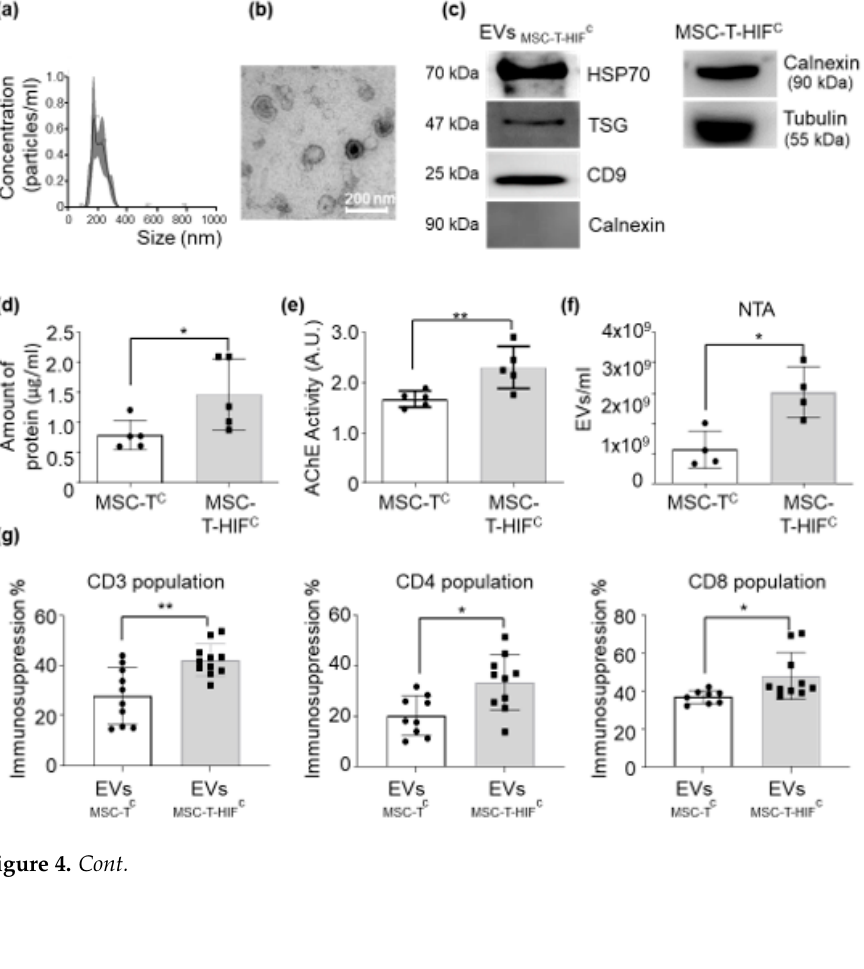
Figure 4. MSC-T-HIF c -derived EVs (EV MSC-T-HIFc ) display enhanced immunosuppression properties. ( a ) Representative images of EVs collected from MSC-T-HIFc evaluated by nanoparticle tracking analysis (NTA). ( b ) Representative electron microscopy images of isolated EVs collected from MSC-T-HIFc. Scale bar: 200 nm. ( c ) Representative Western blots of Hsp70, TSG101 and CD9 pro- teins in EVs. Absence of calnexin demonstrates a pure EV preparation. Cells were used as cal- nexin-positive controls ( d ) Concentration of protein of EVs extracted from 100 mL of culture me- dium from 1 × 10 7 cells that were resuspended in 100 μ L of PBS. Graphs represent mean ± SD of six independent experiments. Paired t -test was used for statistics. ( e ) Quantification of acetylcho- linesterase activity in EV MSC-T c and EV MSC-T-HIF c . Values are represented as relative to the EV MSC-T c value. Graph represents mean ± SD of three independent experiments. Paired t -test was used for statistics. ( f ) Amount of EVs per milliliter in the supernatant of the same number of MSC-Tc and MSC-T-HIFc measured by NTA. Graphs represent mean ± SD of three independent experiments. Unpaired t -test was used for statistics. ( g ) Peripheral blood mononuclear cells (PBMCs) were stained with CFSE and stimulated with anti-CD3 and anti-CD28 beads in the presence or absence of EV MSC-Tc or EV MSC-T-HIFc . After 6 days, cells were stained with anti-CD3, anti-CD4 and anti-CD8 antibodies and the proliferation of T-cell subsets was determined by flow cytometry of CFSE dilu- tion. Suppression (percentage) was calculated based on the expansion index. Graph represents mean ± SD of seven independent experiments. Unpaired t -test was used for statistics. ( h ) Repre- sentative Western blots of IDO and PD-L1 proteins in EV MSC-Tc and EV MSC-T-HIFc . Expression levels were quantified by densitometry relative to EV MSC-Tc . CD9 was used as a loading control. Graph